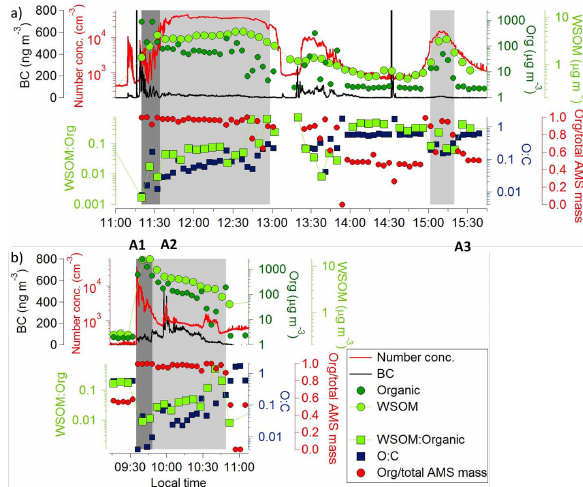
Fig. 6. Plume chemical composition measured by AMS for the three plume ages (A1, A2, A3) and marine background aerosol on 17 July (a) and 18 July (b) . Light-gray shading designates plume ages A2 and A3, and dark-gray shading represents the fresh plume (A1). The ratios O:C and WSOM:Org increase with plume age both days, and an absolute increase of WSOM is observed on 17